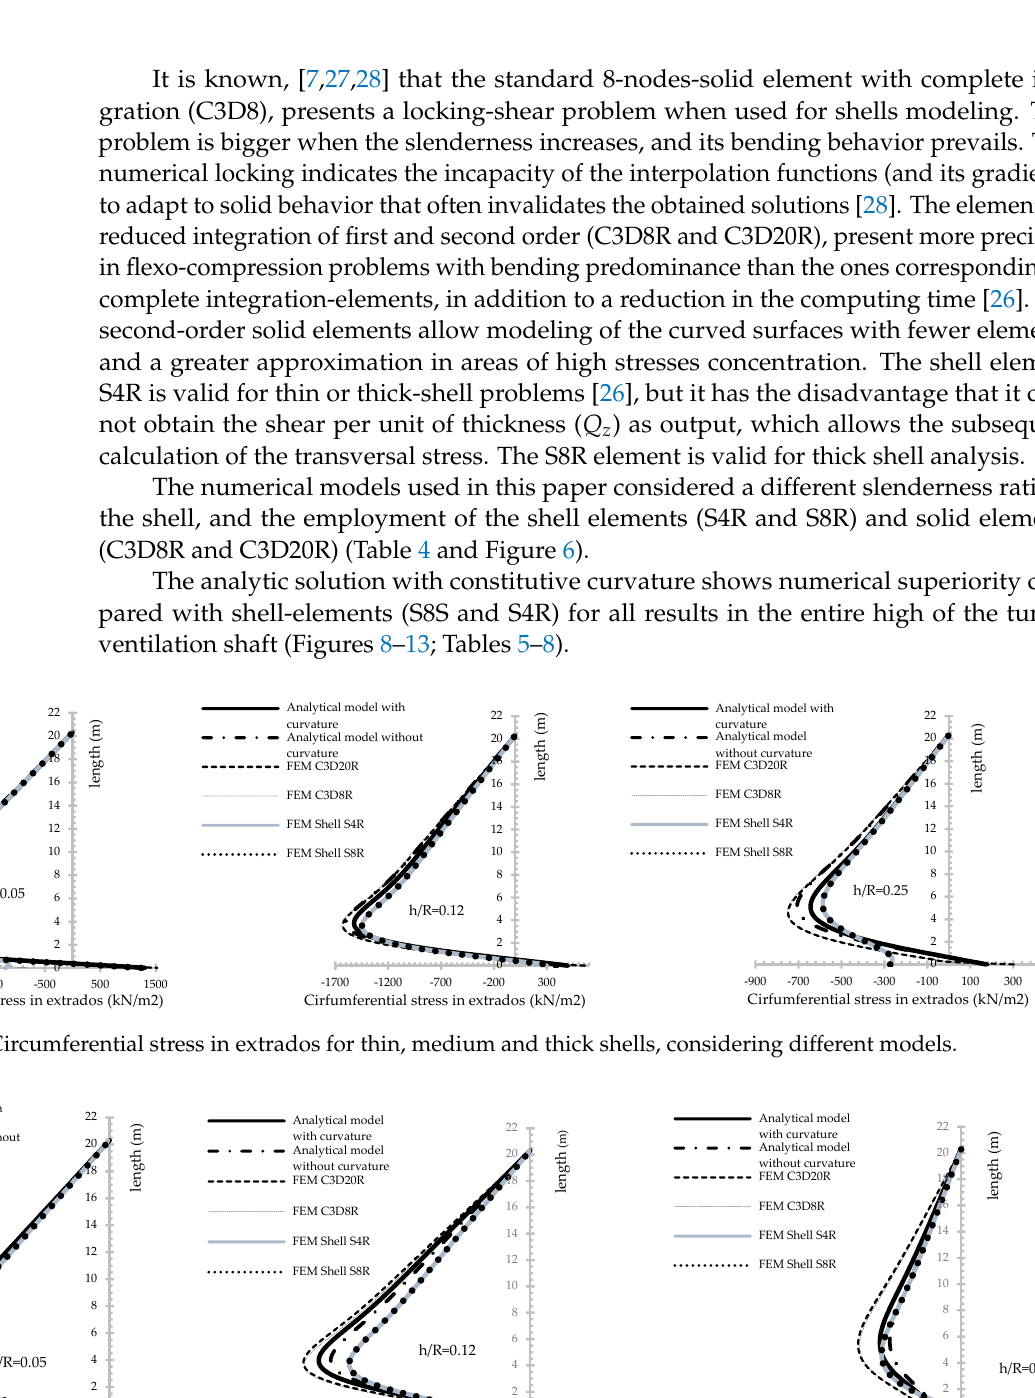
Table 8. Maximum longitudinal stress in intrados for different slenderness ratio.